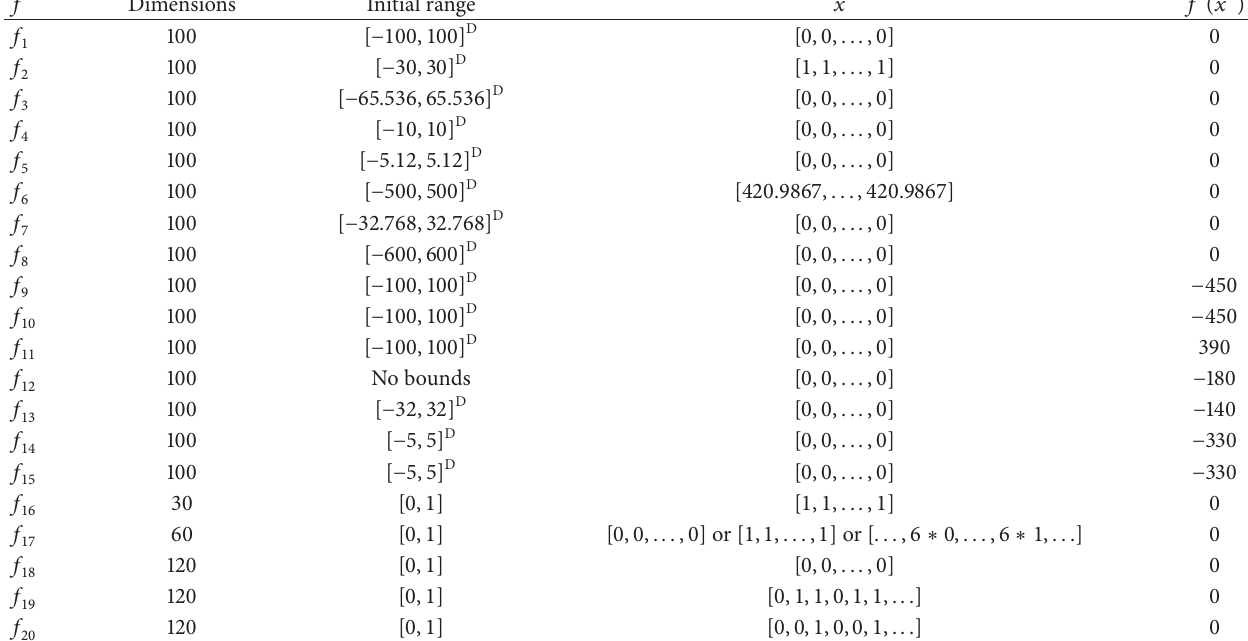
Table 9: Parameters of the test